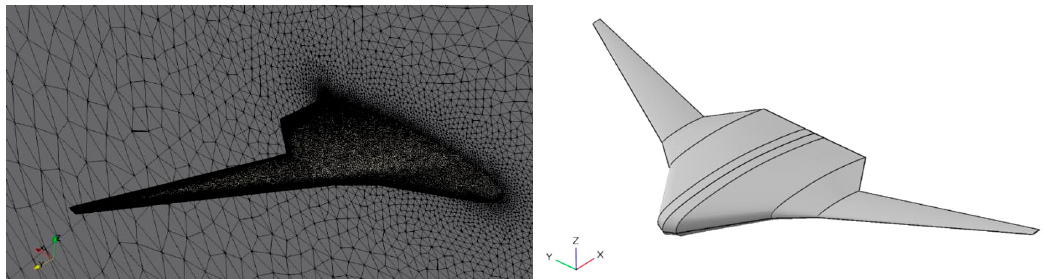
Figure 8. Airframe geometry of SE²A-LR aircraft visualized in OpenVSP.